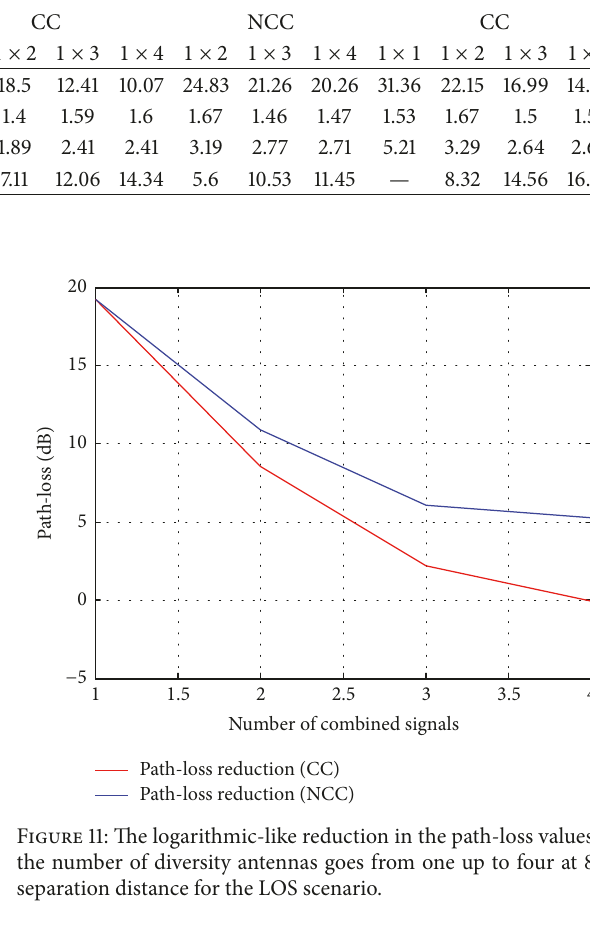
Table 2: FIM parameters along with the average path-loss enhancements of receiver diversity for all the cases of SIMO reception. Scenario